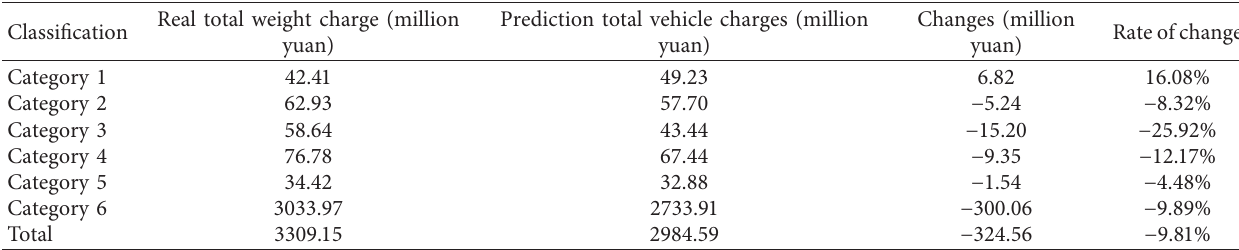
Table 9: Weight charge and static translation scheme comparison.